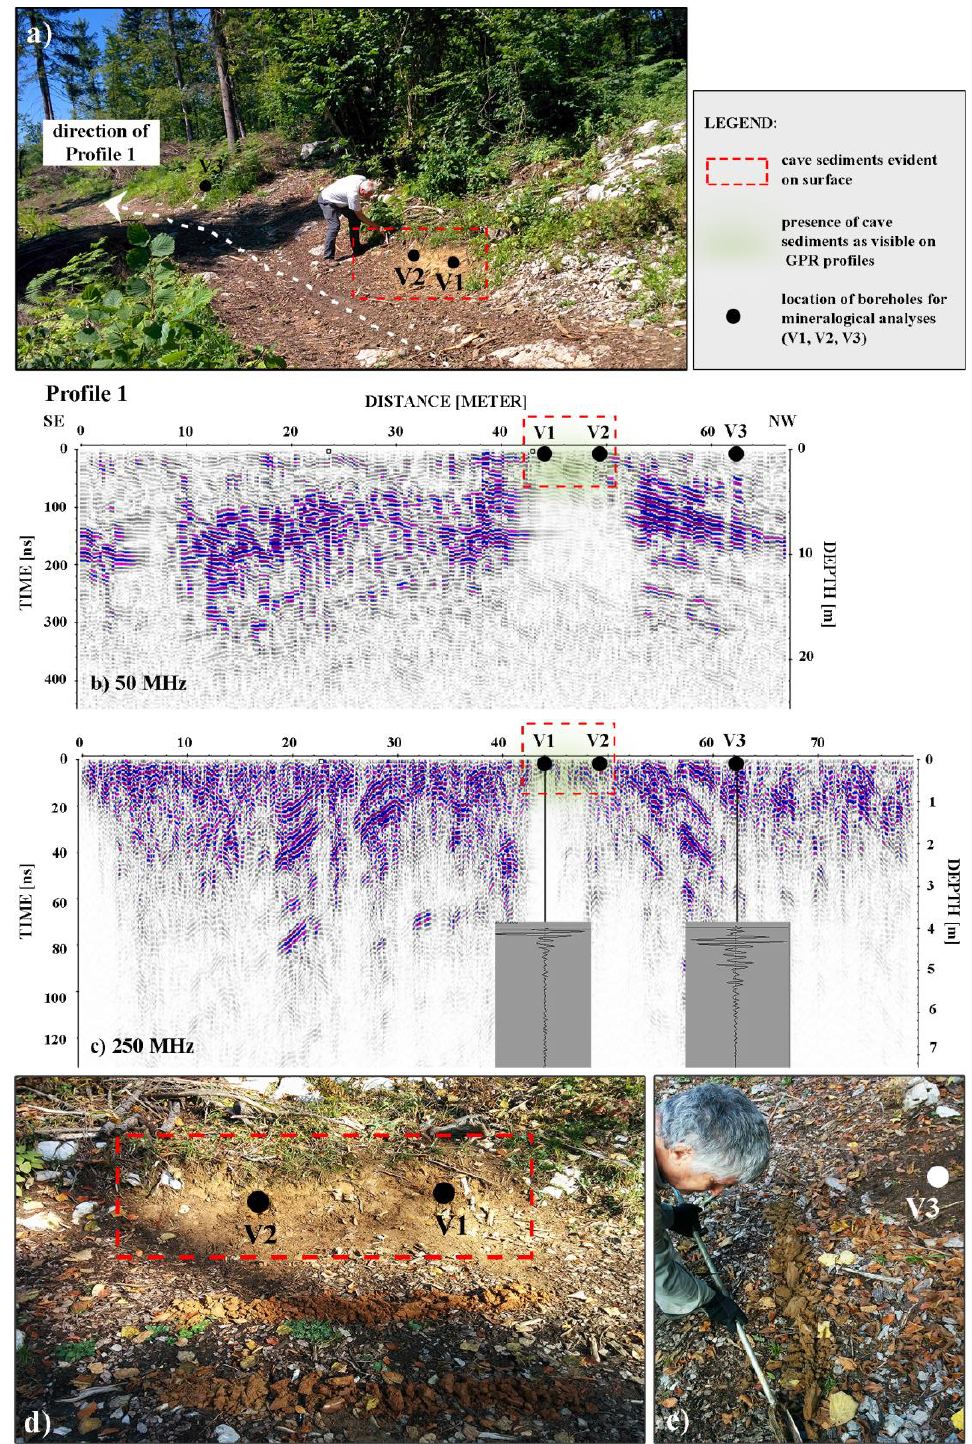
Figure 7. ( a ) Direction of Profile 1 acquired over an area of cave sediments; ( b ) A processed radargram with highly attenuated area presenting cave sediments with 50 MHz antenna and ( c ) with 250 MHz antenna (vertical exaggeration 1:4); ( d ) Locations of V1 and V2 boreholes in cave sediments; ( e ) Sampling with a manual drilling machine in soils on carbonate rocks (V3).